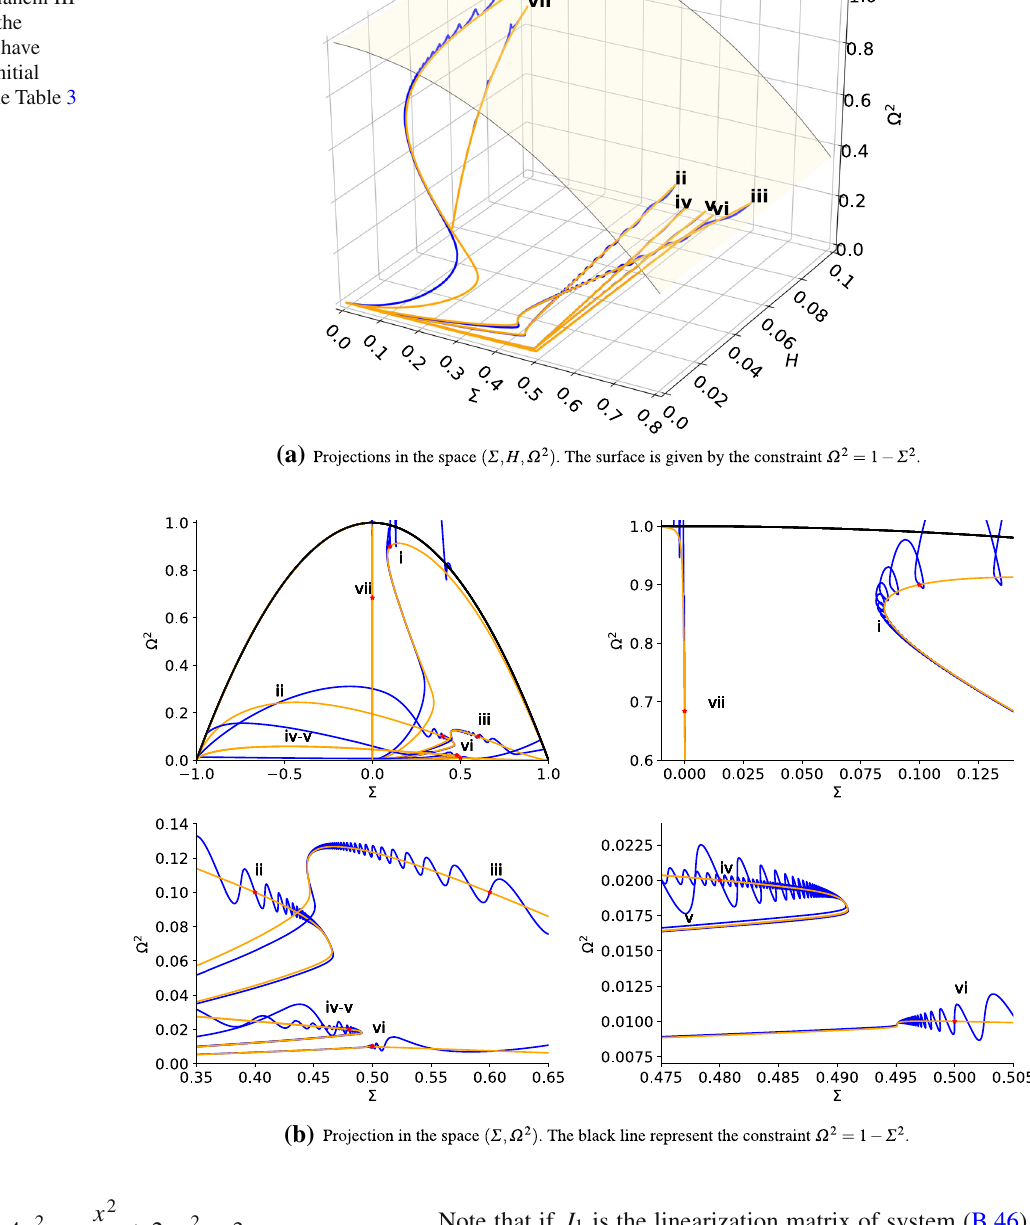
Fig. 13 Some solutions of the full system (46) (blue) and time-averaged system (78) (orange) for the LRS Bianchi III metric when γ = 0, in the projection Ω k = 0. We have used for both systems initial data sets presented in the Table